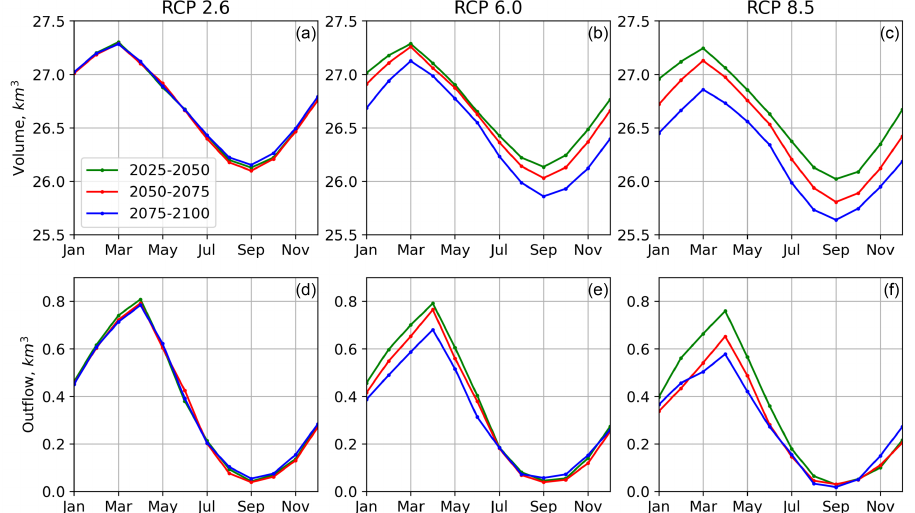
Figure 5. Inter-annual variations of the Small Aral Sea water volume ( a – c ) and the Kokaral outflow ( d – f ) depending on the RCP scenarios averaged for the periods of the second, third and fourth quarters of the 21st